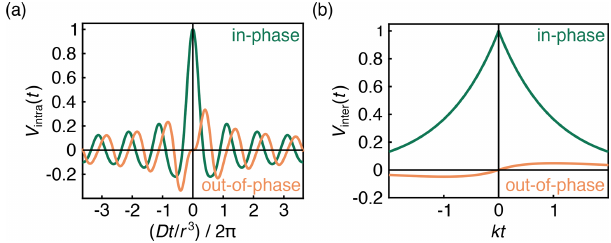
Figure 3. (a) The theoretical powder-averaged polarized DEER sig- nal for a single A–B spin pair (Eq. 6). (b) The theoretical DEER time trace for an A spin coupled to a uniform three-dimensional distribution of B spins at full spin polarization (Eq. 8, (cid:15) =